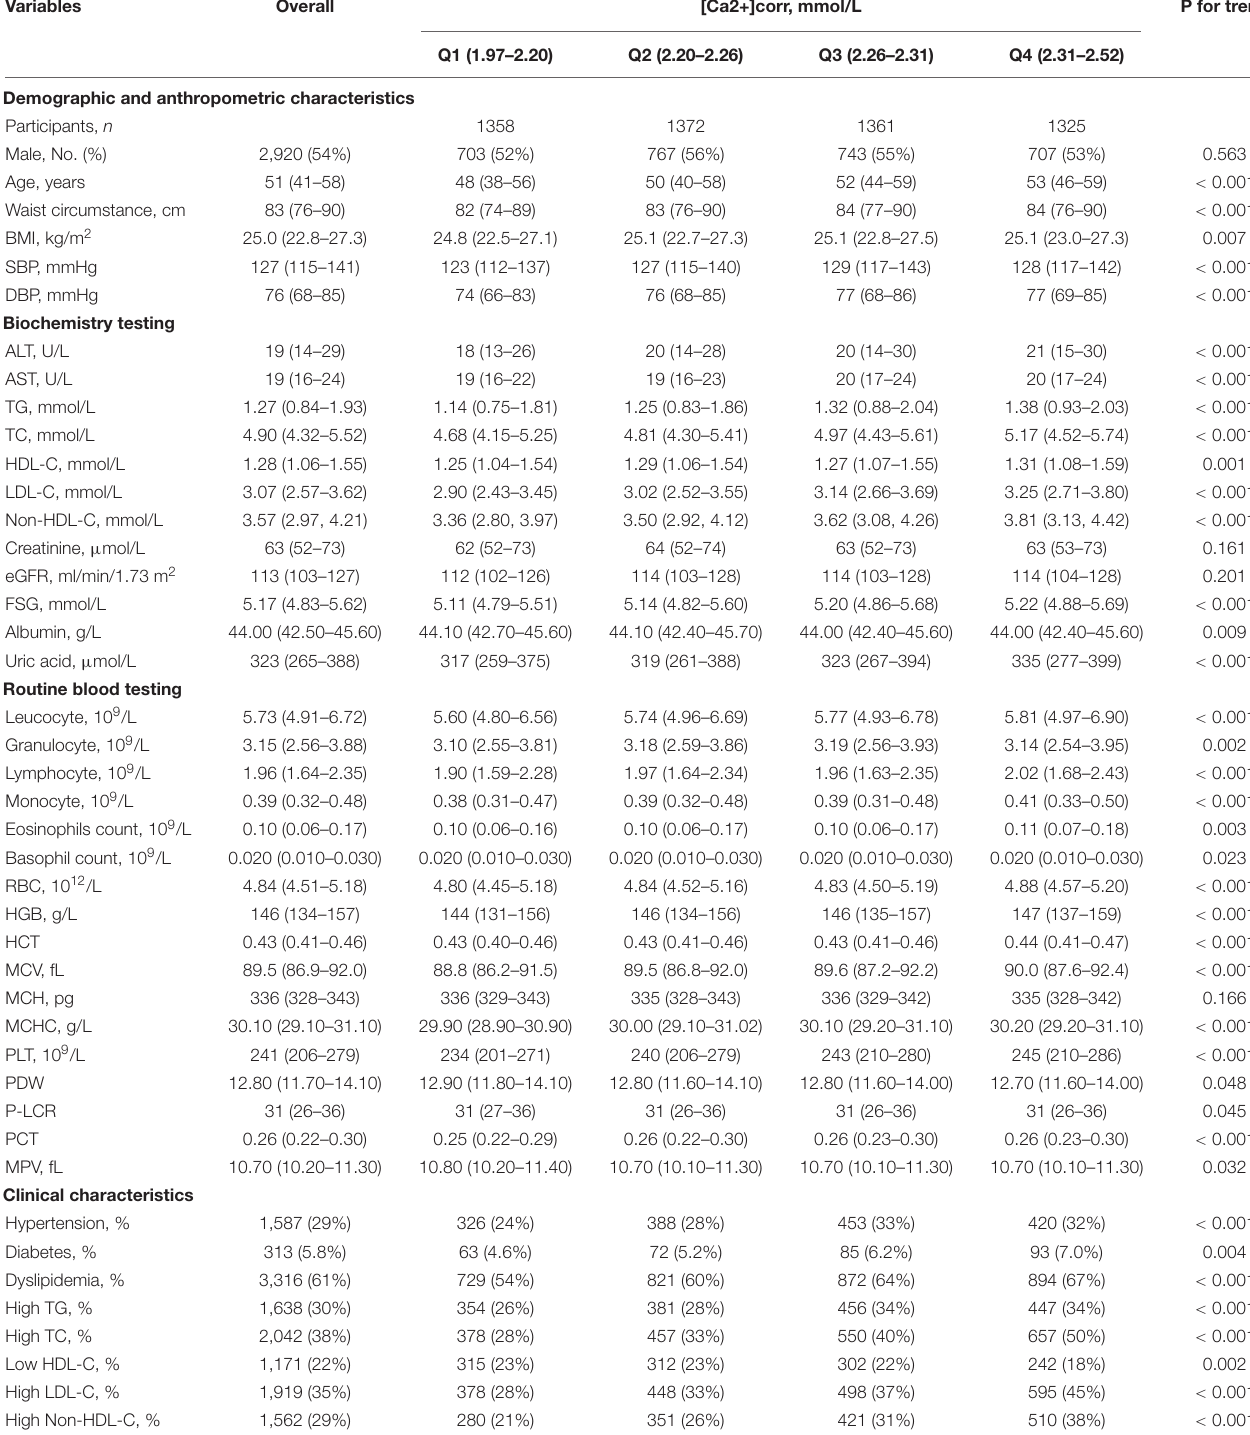
TABLE 1 | Participant demographics and laboratory parameters according to [Ca2+]corr quartiles ( N =